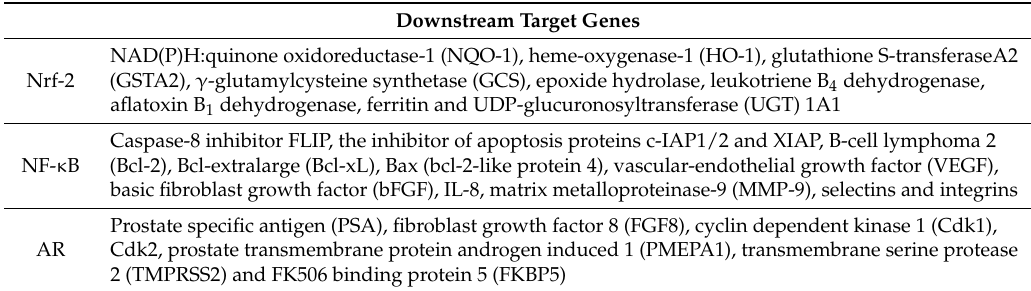
Table 1. Downstream target genes of Nrf-2, NF- κ B and